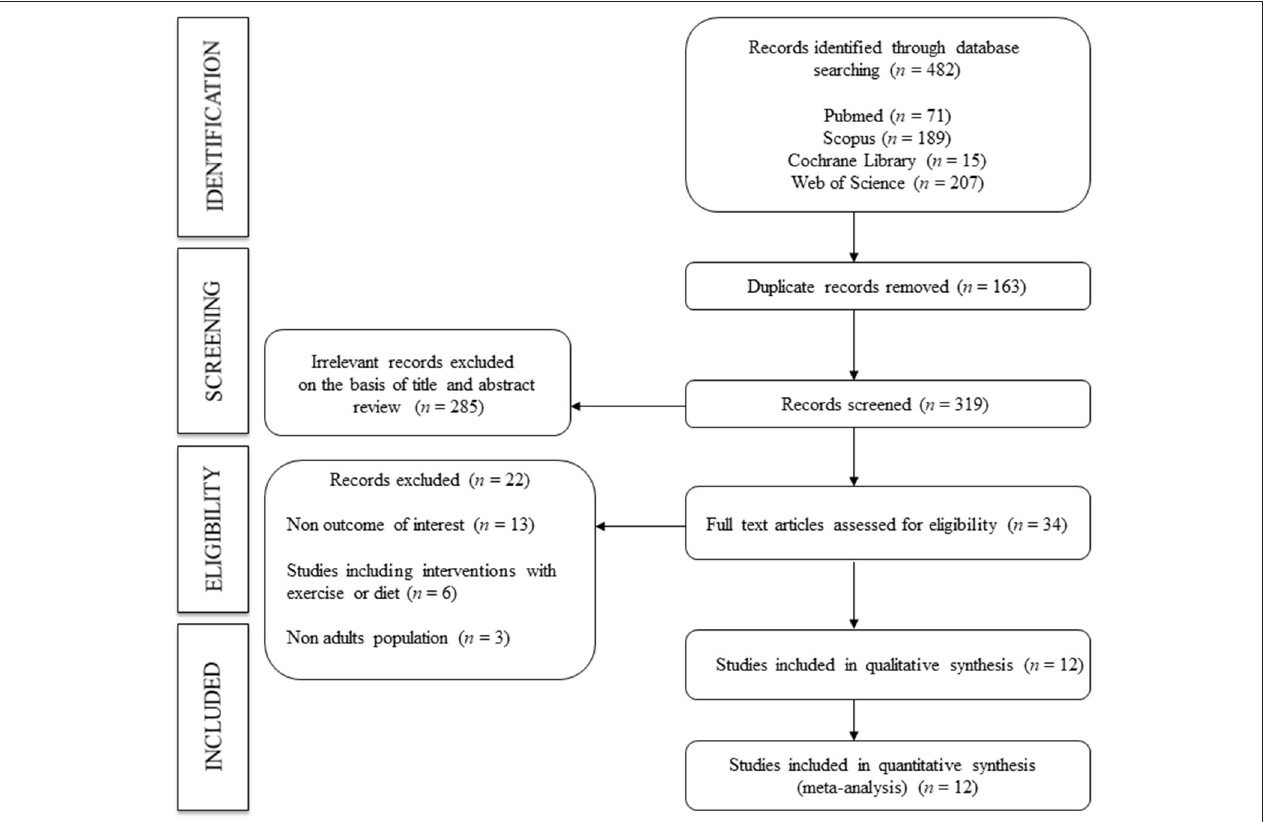
FIGURE 1 | Flowchart: Search